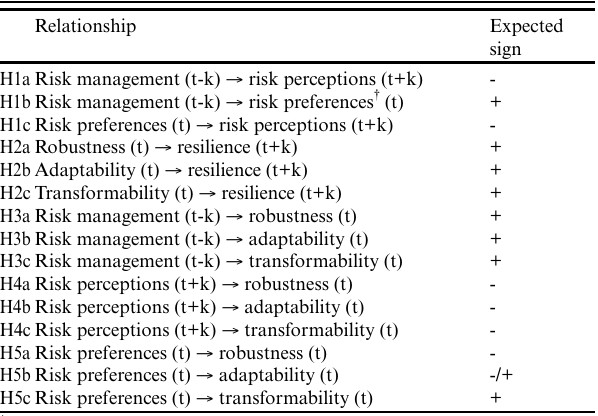
Table 1. Overview of the hypothesized relationships and their expected signs. + positive relationship, - negative relationship, -/+ the relationship will be determined by the study Relationship Expected